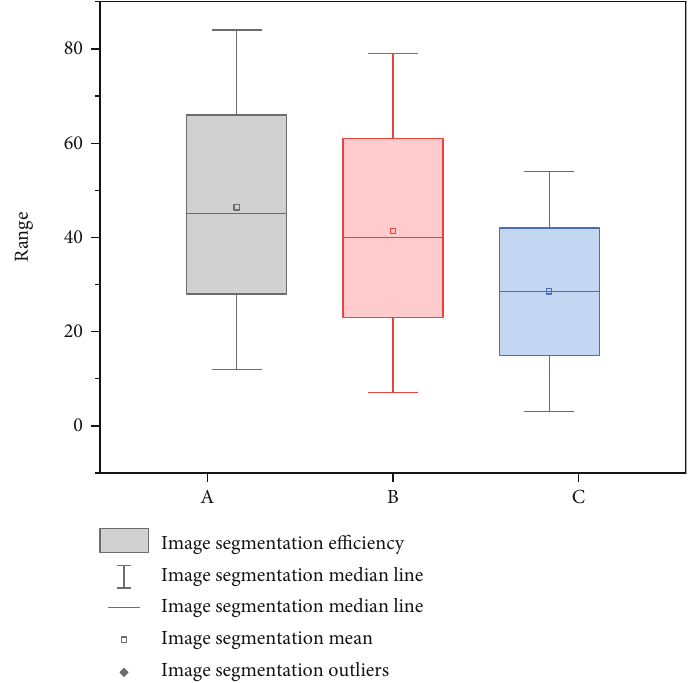
Figure 6: Image segmentation before and after layer feature fusion data